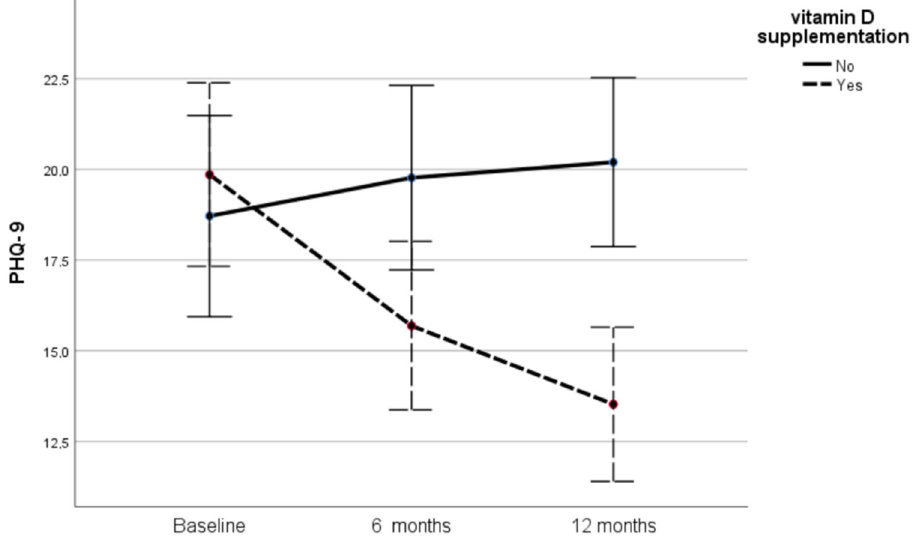
Figure 3. Changes in PHQ-9 scores in the two groups during the study.